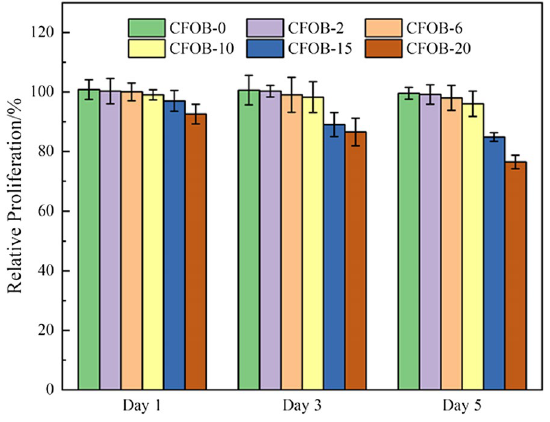
Fig. 6 CCK-8 experiment results of CFOB with different OBSP